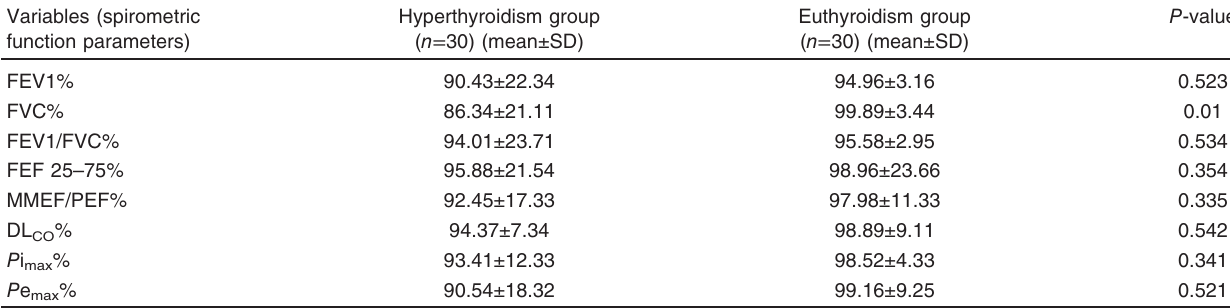
Table 5 Comparison of spirometric function parameters between hyperthyroid and euthyroid groups Variables (spirometric function parameters)